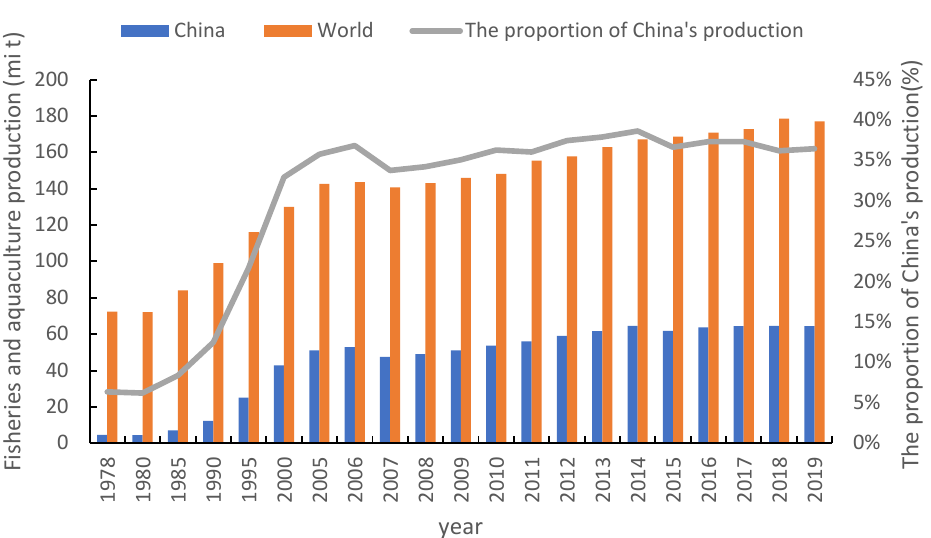
Figure 1. The trend of total fishery aquatic products in China and the world since 1978. Data Source: China Fisheries Statistical Yearbook (1979–2020) [6] and The State of World Fisheries and Aquacul- ture (2002, 2004, 2006, 2008, 2010, 2012, 2014, 2016, 2018, 2020) [7].